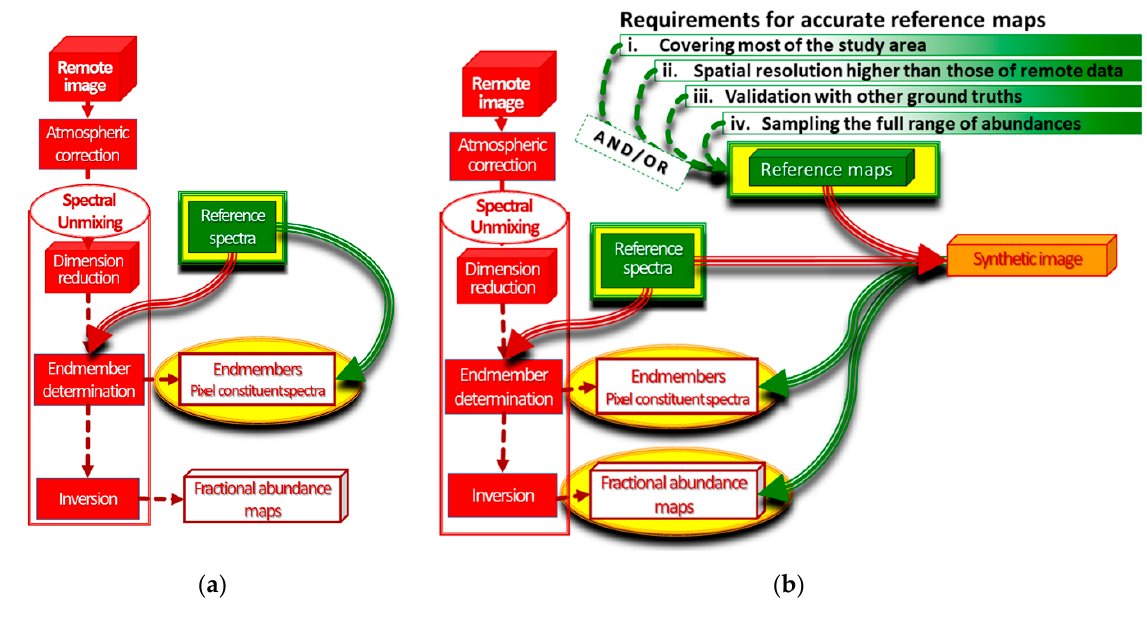
Figure 1. The flowcharts of validation methods: ( a ) spectral validation method; ( b ) spectral and spatial validation methods using synthetic image.